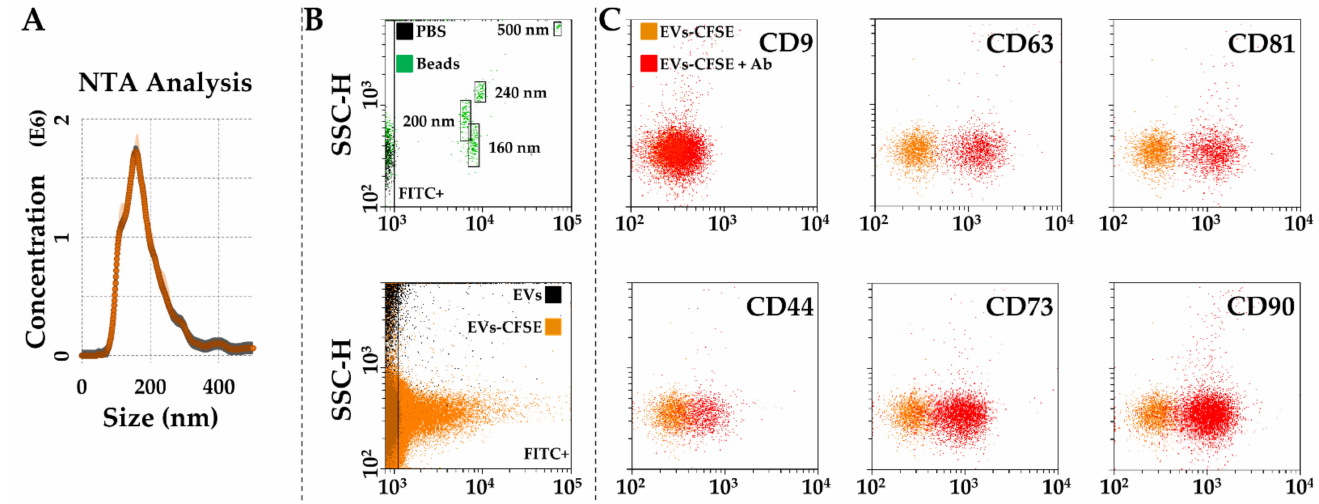
Figure 5. Characterization of SF-treated BMSC-EVs. ( A ), EVs size analysis from NTA data. ( B ), flow cytometer was first calibrated to score FITC-fluorescent particles of nanometer scale (upper panel, starting from 160 nm). EVs were CFSE stained to allow their identification and gating in the FITC channel (lower panel). ( C ), after gating, CFSE + EVs showed positive staining for extracellular vesicle defining molecules CD63 and CD81, and MSC markers CD44, CD73 and CD90. CD9, another EV postulated marker, was barely detectable. Representative cytograms are presented.